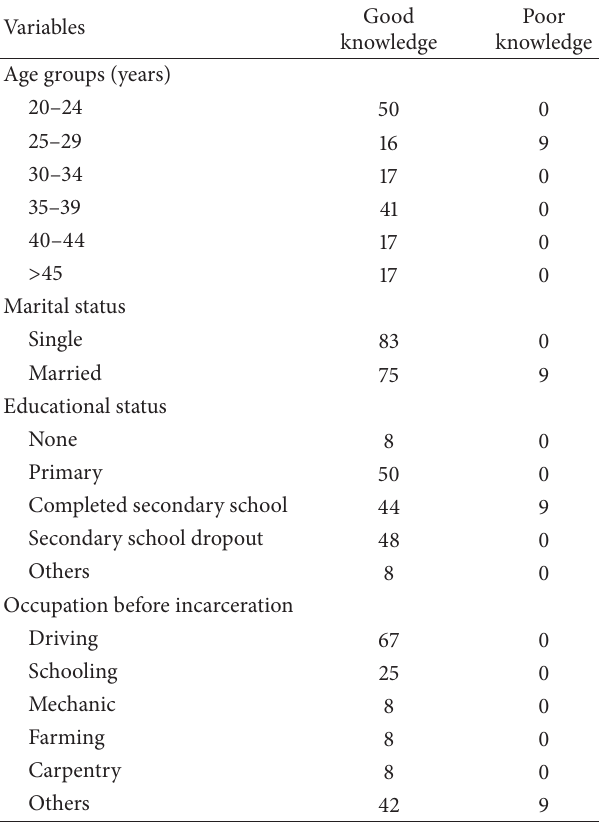
Table 5: Sociodemographic characteristics of respondents and knowledge about HIV/AIDS.